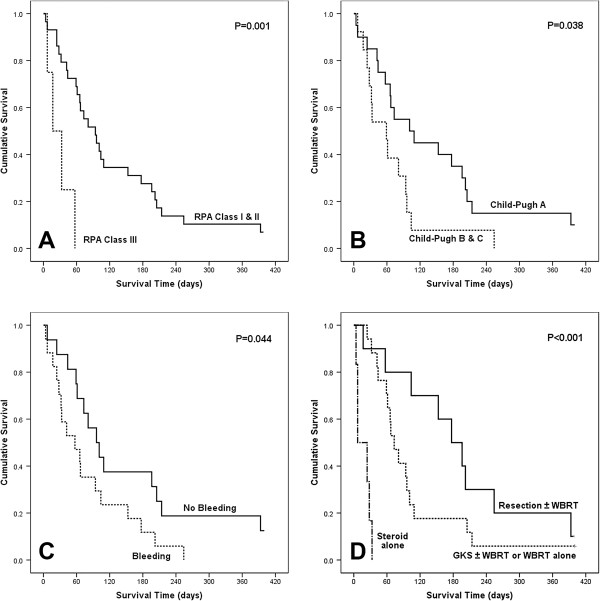
Kaplan-Meier analyses of overall survival for 33 patients according to different predictors. (overall comparison was estimated using a log-rank test). A: RPA class, B: Child-Pugh classification, C: Presence of intratumoral hemorrhage, D: Treatment modality for brain metastasis.